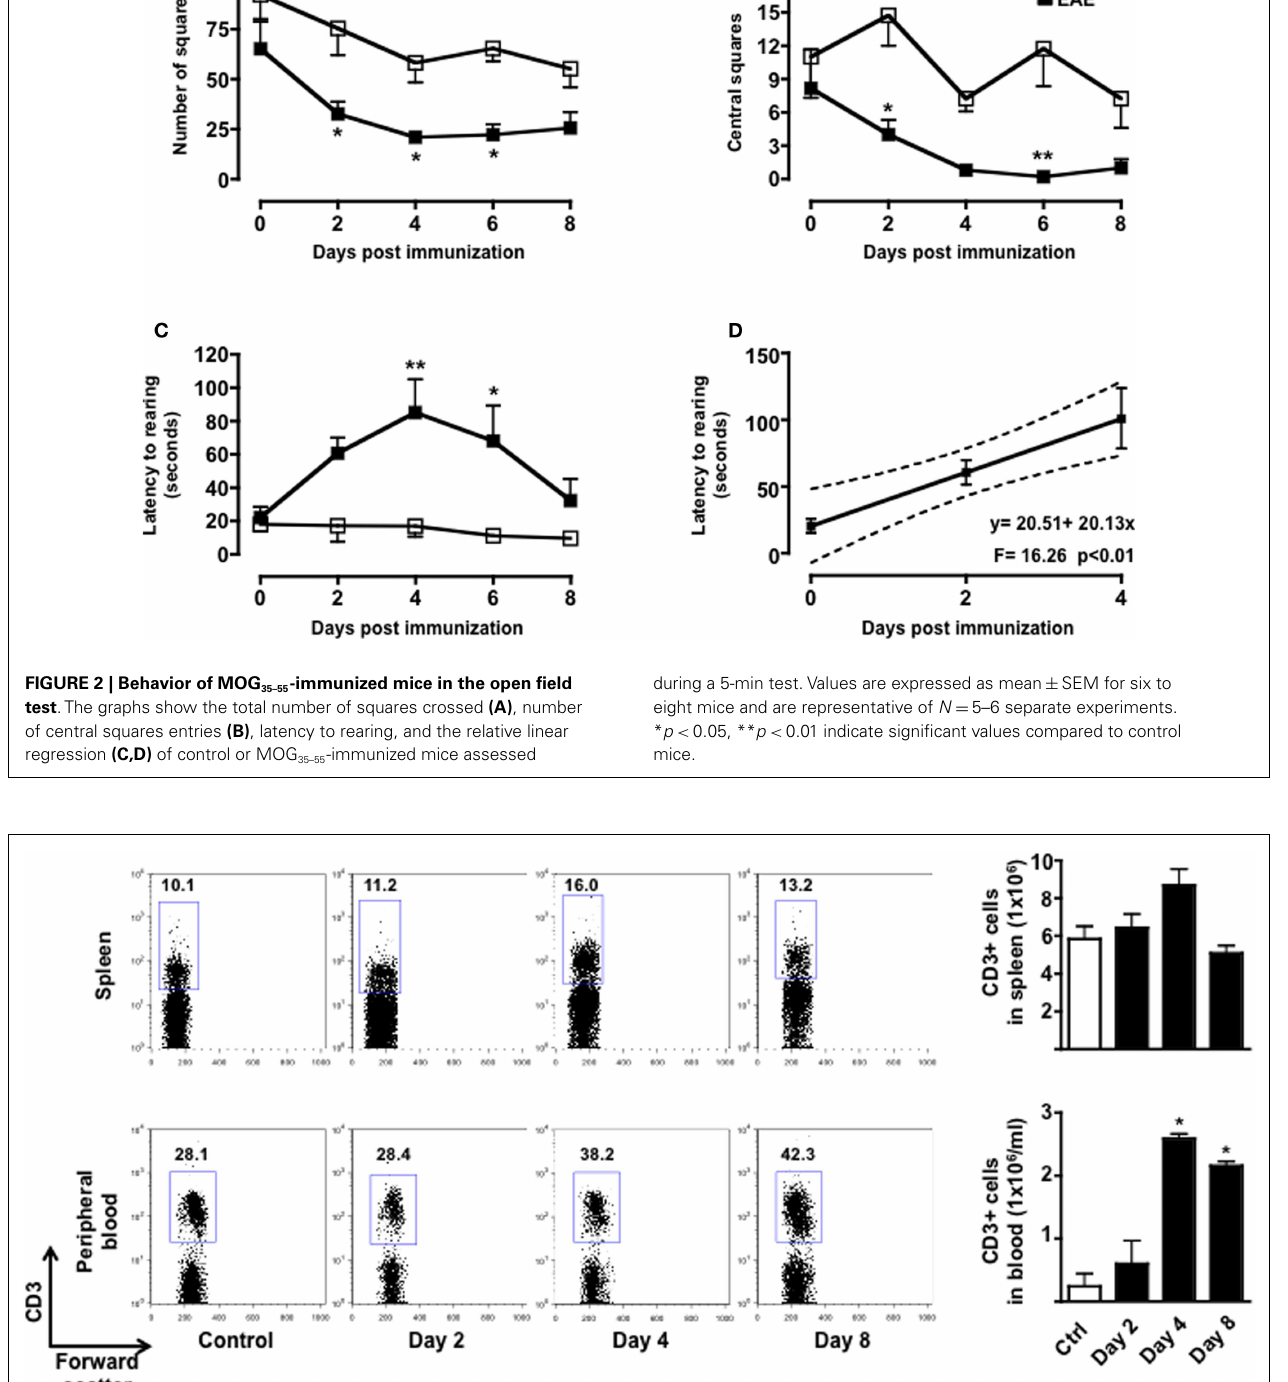
T cells in spleen ( top panels ) or peripheral blood ( bottom panels ) of control or MOG 35–55 -immunized mice.Values are expressed as mean ± SEM for three to four mice. * p < 0.05 indicates significant values compared to control